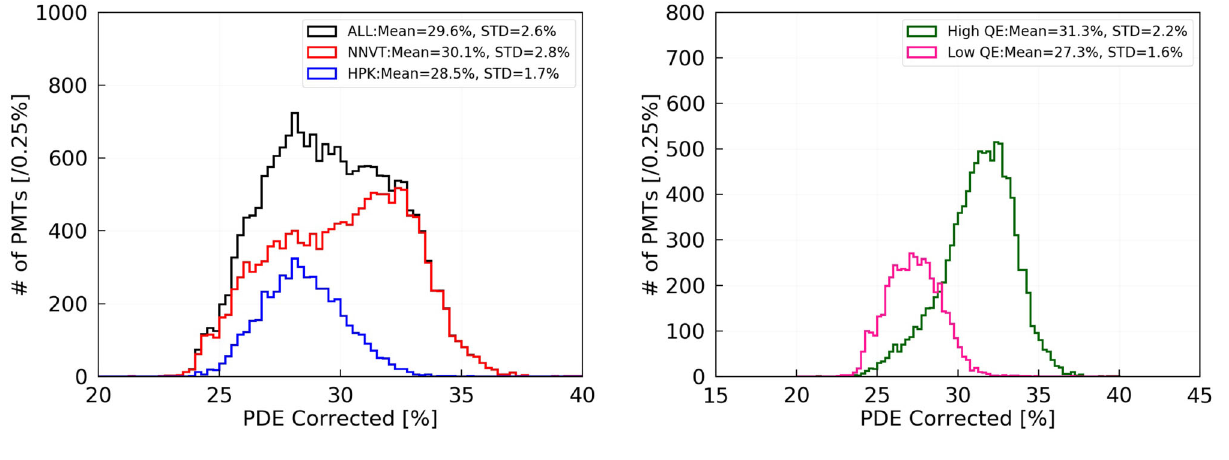
Fig. 19 Corrected PDE distribution of all qualified PMTs (left), and of all NNVT PMTs (right). Black: all PMTs; red: NNVT; blue: HPK; dark green: high-QE MCP-PMTs; deep pink: low-QE